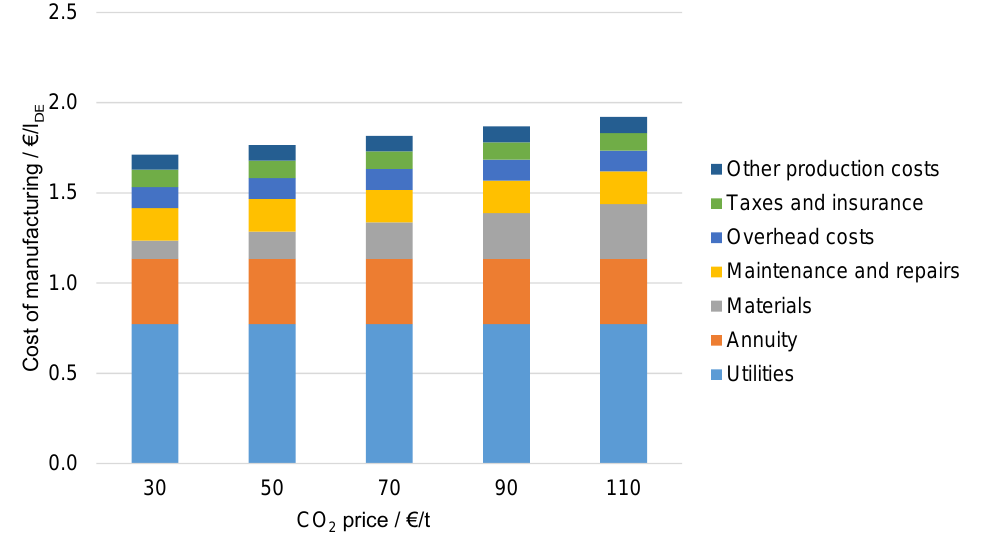
Figure 20. Product production costs as a function of the CO 2 price.